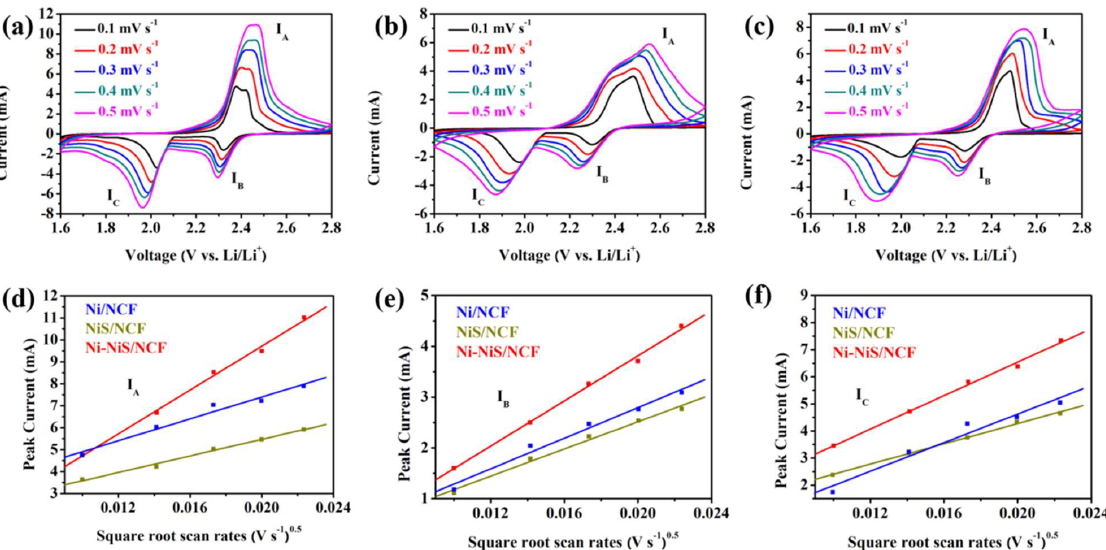
Figure 5. CV curves of the cells with separator coated by ( a ) Ni-NiS/CNT, ( b ) NiS/CNT, and ( c ) Ni/CNT at different sweep speeds. ( d ) I A (anodic oxidation, Li2S2/Li2S → S8 + Li); ( e ) I B (cathodic reduction, S8 → Li2Sx, 3 ≤ x ≤ 8); ( f ) I C (cathodic reduction, Li2Sx → Li2S2/Li2S, 3 ≤ x ≤ 8).